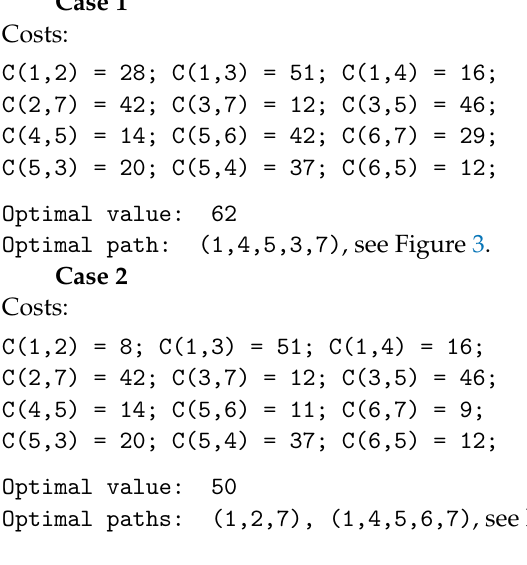
Figure 2. The graph with labeled nodes corresponding to the one in Figure 1. We give two different examples, using different costs (weights) for the various arcs, to show the performance of the algorithm. After providing the costs matrix, we give the optimal value and the optimal path as a sequence of the nodes to be attained at each step. The minimum cost path is also shown in the figures in red